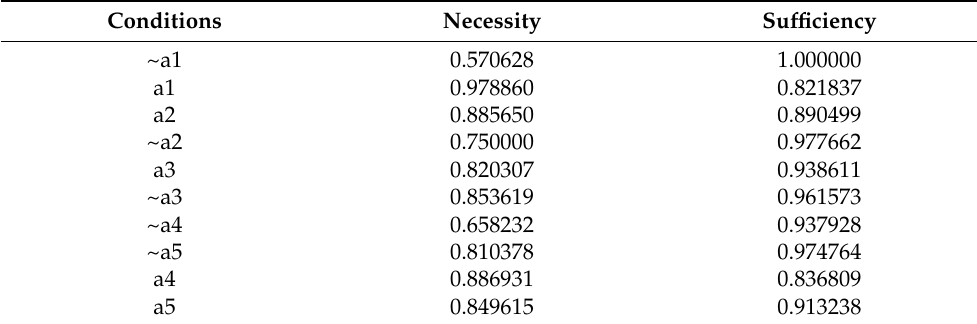
Table A13. Necessity and sufficiency analysis of conditions (outcome ~A3).